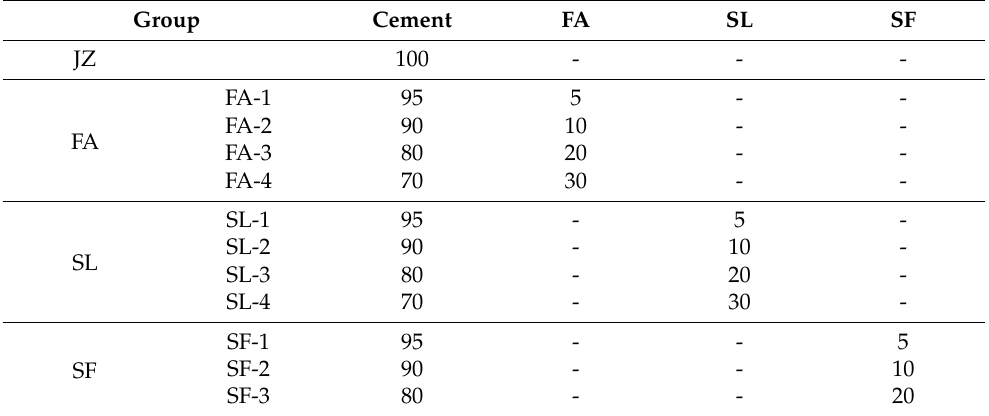
Table 2. Mix proportions of cement